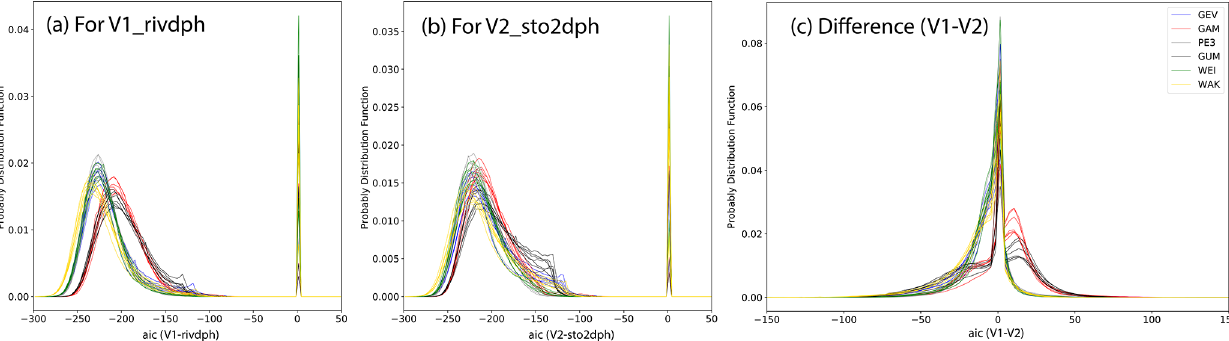
Figure 3. Overall performance of FFA for (a) V 1 (river water depth) and (b) V 2 (water storage). The performance AIC over all the land grids are collected and displayed as a histogram. Panel (c) is the AIC difference between (a) and (b) . Negative difference indicates better performance of FFA for V 1. Different colors represent different fitting distributions and the multiple lines in a specific color represents results driven by different runoff inputs. The types of runoff inputs are not specified in these three